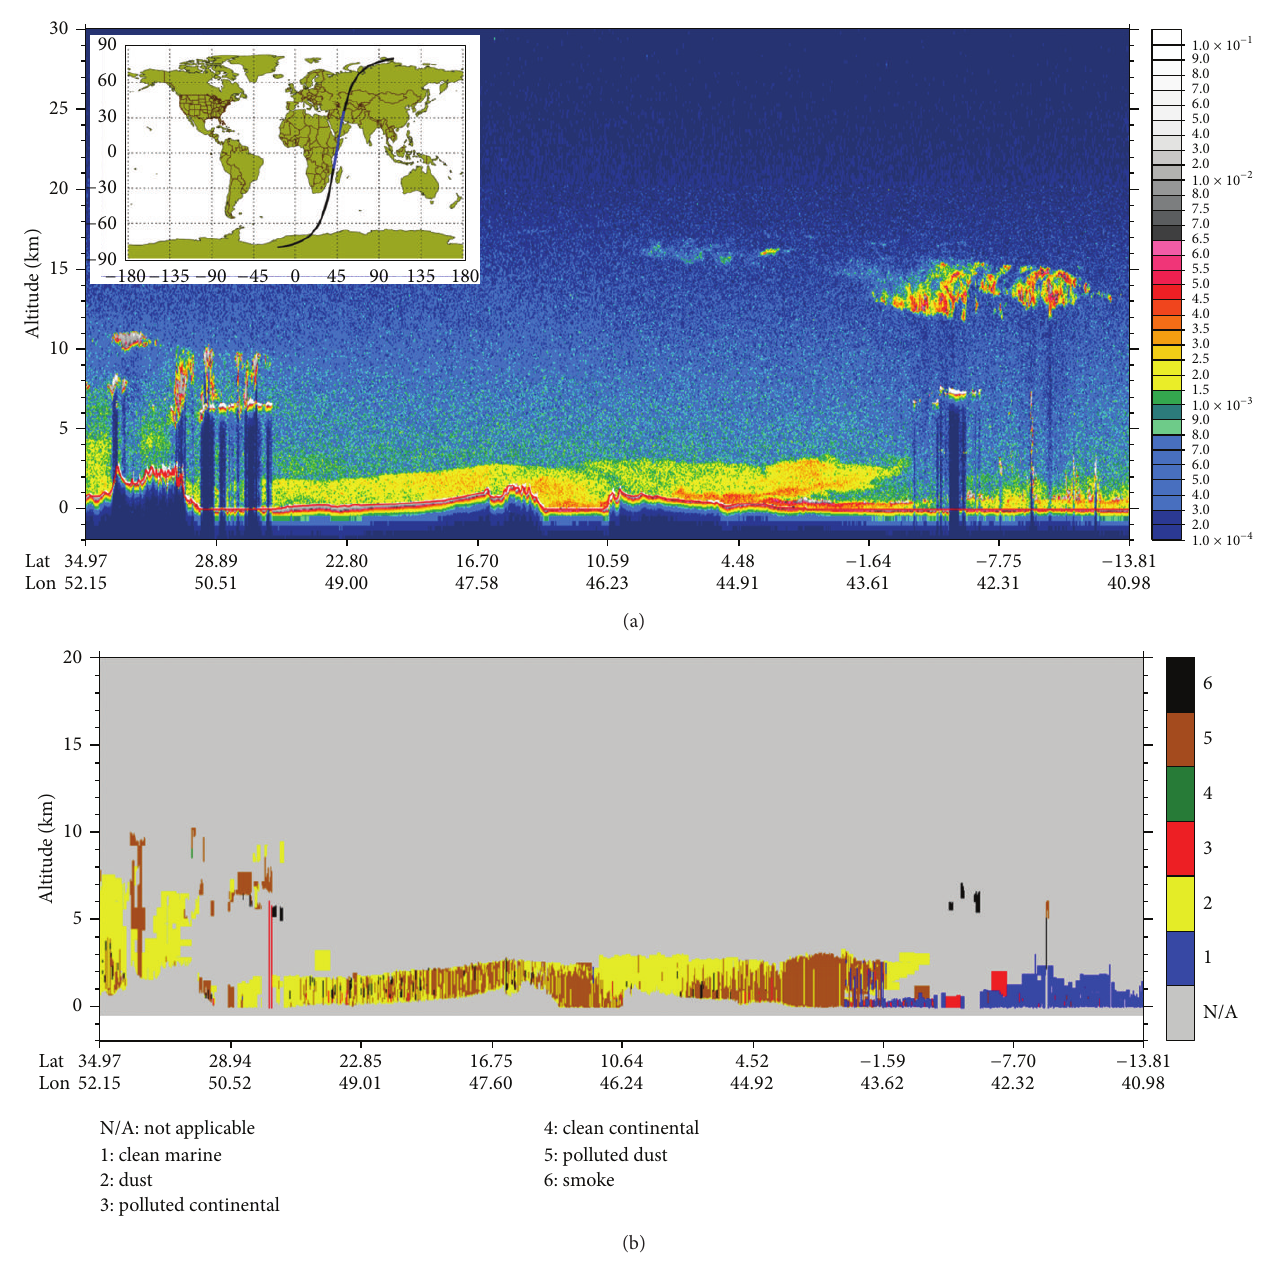
Figure 5: CALIPSO (a) total attenuated backscatter at 532 nm of a dust storm event as measured by the night-time CALIPSO overpass over the inland Saudi Arabia (at 2238 to 2251UTC 11 March 2008) and (b) aerosol subtype over the same area. The surface elevation is shown as a thick black line. The inset map shows the path of CALIPSO overpass over the globe (black line) and the study region (red